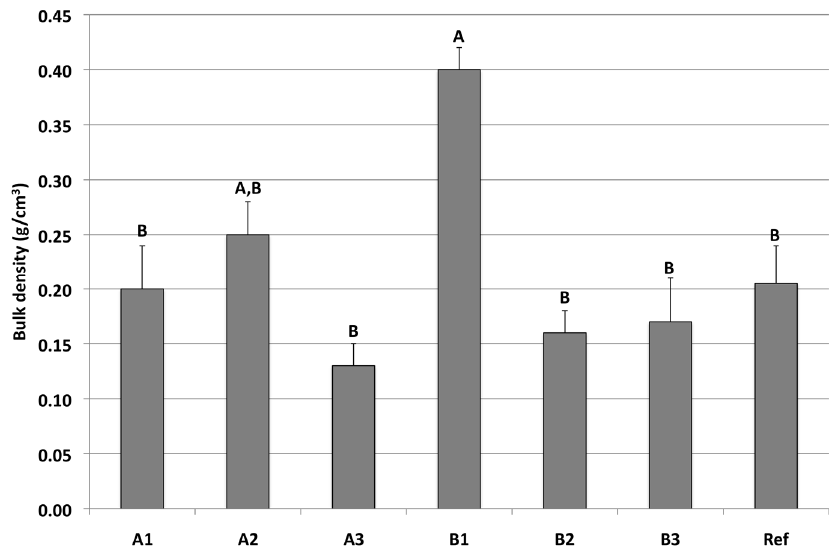
Figure 4. Soil bulk density at the sampling sites in the CWU. Different letters indicate a significant difference α = 0.05. Error bars represent standard error of the mean.